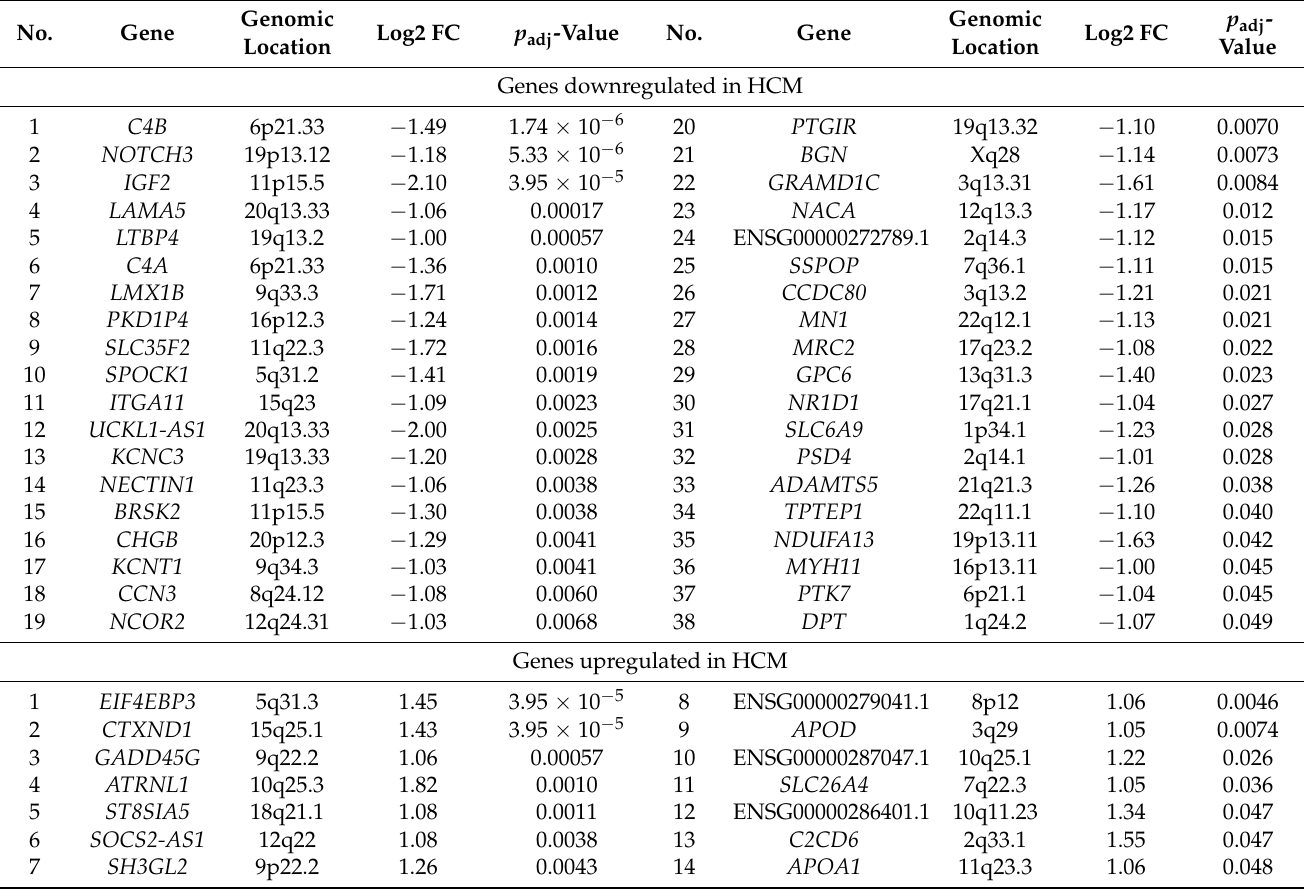
Table 2. Differentially expressed genes identified in the LV myocardial samples of patients with HCM when compared to AS (padj < 0.05, |Log2FC| >